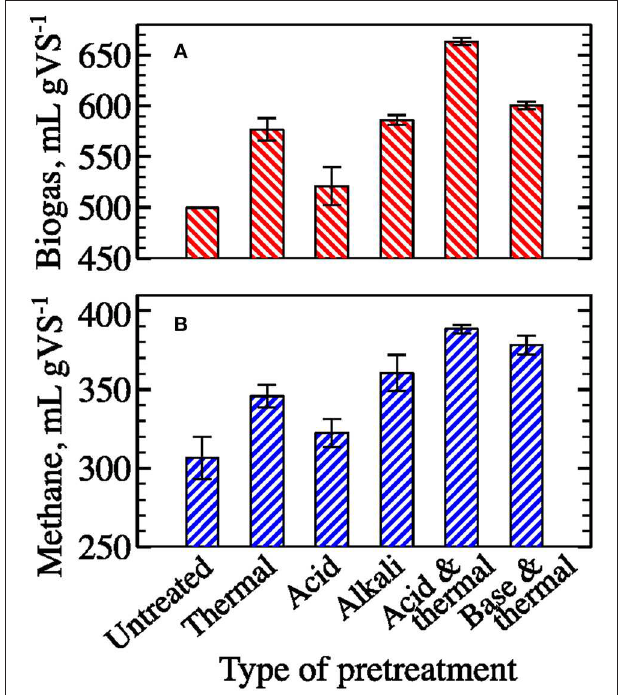
FIGURE 4 | Effect of pretreatment on ultimate specific biogas (A) and methane (B) yields from filamentous algal biomass (mean ± 1 S.D. of three